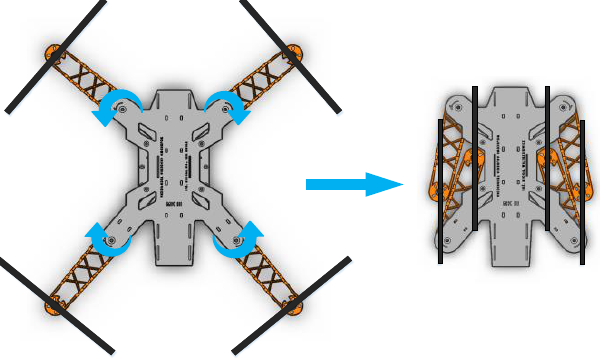
Figure 4. Operating principle of the frame foldable arms [5].